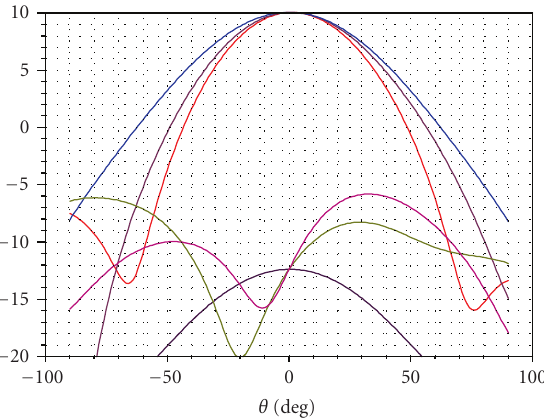
Figure 9: Tx/Rx active module connected to the radiating element.